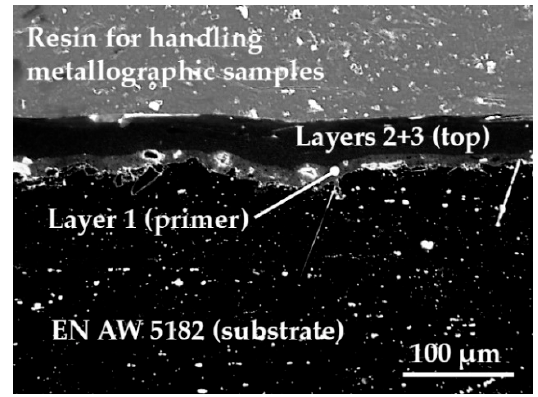
Figure 1. EN AW-5182 Al-Mg alloy substrate with PTFE coating.